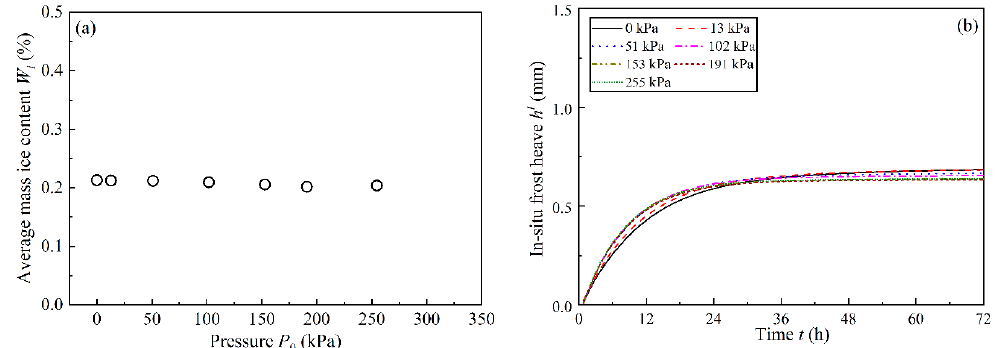
Figure 6. ( a ) Variations of the average mass ice content with external pressure, ( b ) variation of in situ frost heave with freezing time under external pressures.